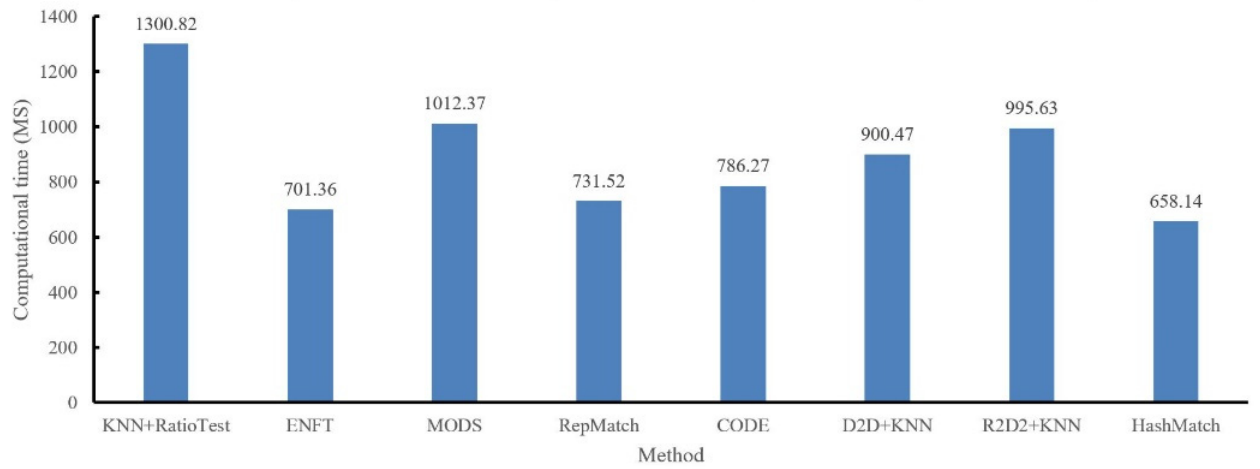
Figure 8. The calculation time of each method. According to these statistical results, the proposed method, HashMatch, has the fastest speed.